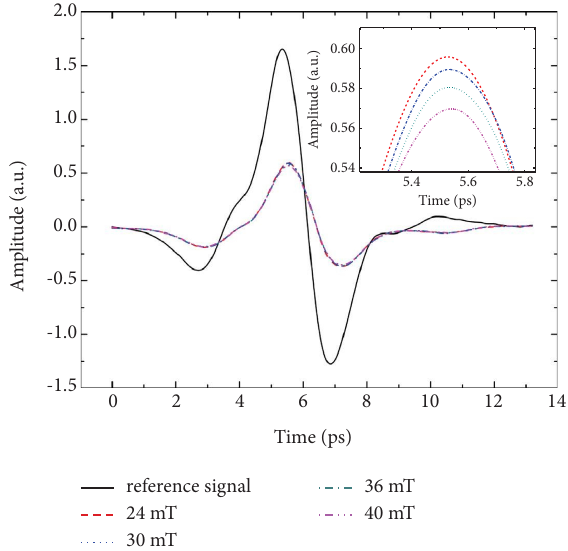
Figure 10: THz time-domain spectra of MWCNT aqueous dis- persion under diferent MF intensities.